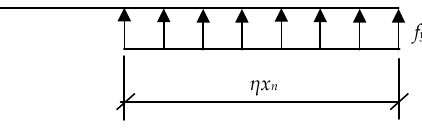
Figure 11. Equivalence of web plate for the small eccentric SC wall.